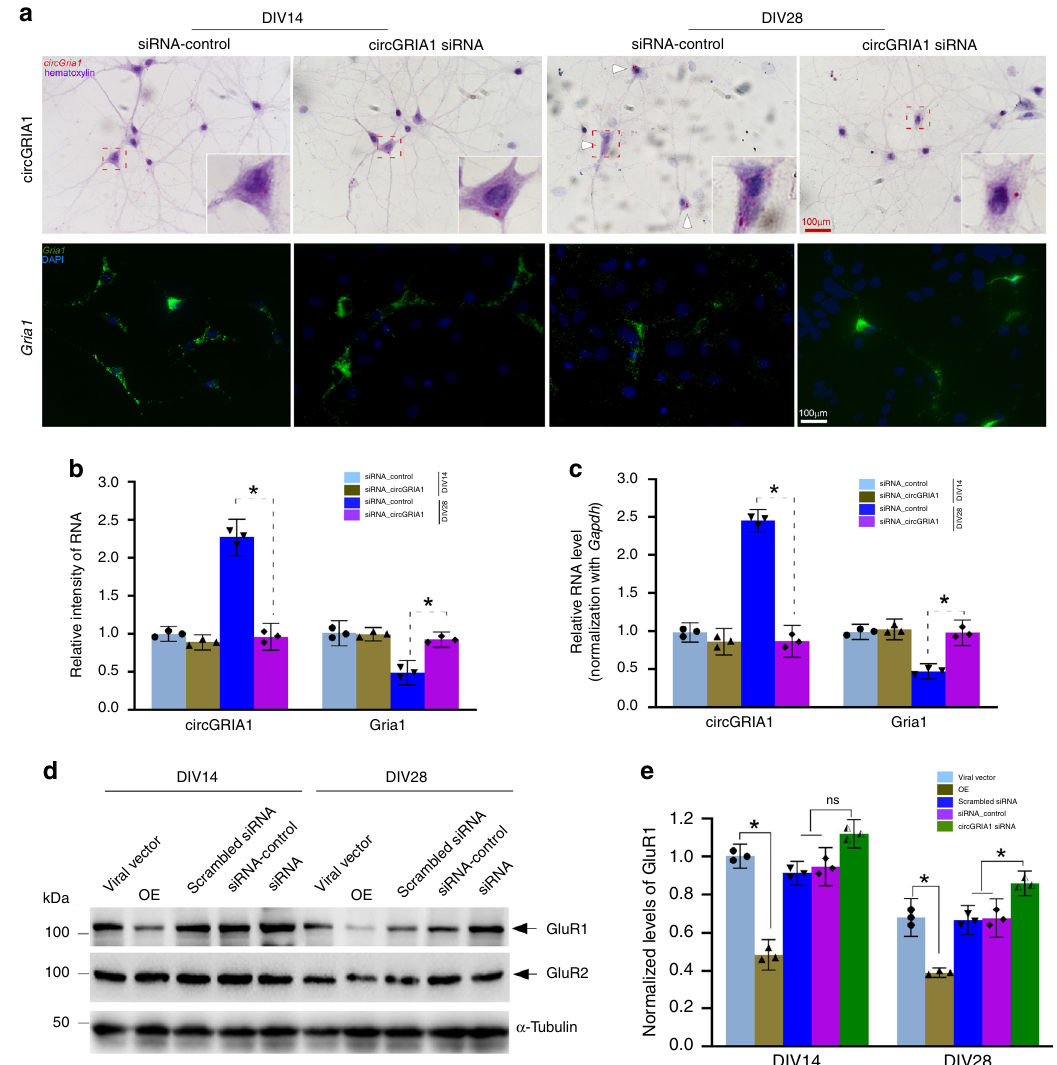
Fig. 4 CircGRIA1 negatively regulates Gria1 mRNA expression. a Representative images of BASEscope and RNAscope ISH showing circGRIA1 and Gria1 expression in hippocampal cultures of male fetal macaque at DIV14 and DIV28. The images are representative of three independent experiment of each sample from 2 to 3 fetal cultures per group. Red boxes indicate areas magni fi ed. Scale bar, 100 μ m. b Average intensities of circGRIA1 and Gria1 signals per neuron illustrated in ( a ) were quanti fi ed by use of Image J. Data are present as mean ± S.D. ( n = 30 – 39 per group; * p < 0.01), p values were calculated using two-tailed Student ’ s t test or one-way ANOVA with Sidak ’ s correction for multiple comparisons. c Negative correlation between nascent circGRIA1 and Gria1 expression. Data are present as mean ± S.D. Each bar represents the average of three independent experiment; error bars denote S.D.; * p < 0.05, p values were calculated using two-tailed Student ’ s t test or one-way ANOVA with Sidak ’ s correction for multiple comparisons. d Protein extracts from DIV14, DIV28 male fetal macaque hippocampal neurons infected at DIV5 with viral circGRIA1, or siRNAs against circGRIA1 or control, were immunoblotted with GluR1 antibody. α -Tubulin was loading control. The blots represent three independent experiment of each hippocampal culture from 2 to 3 male fetal macaques . e Relative intensities of immunobloted signals of GluR1 illustrated in ( d ) were quanti fi ed by use of Image J. Data are present as mean ± S.D. Each bar represents the average of three independent experiment; error bars denote S.D.; n.s. no signi fi cance; * p < 0.05, p values were calculated using two- tailed Student ’ s t test or one-way ANOVA with Sidak ’ s correction or two-way ANOVA with Turkey ’ s correction for multiple comparisons. Source data are provided as a Source Data fi